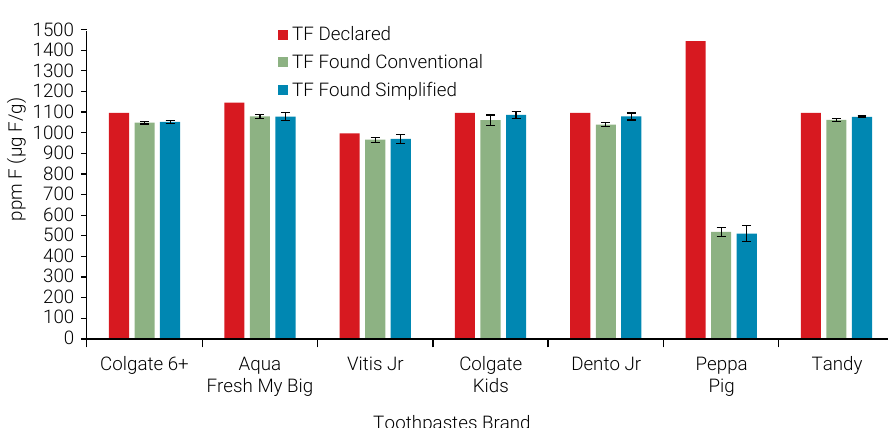
Figure 3. Total fluoride (TF) declared (ppm F) by the manufacturer and concentrations found using the conventional (Ac + ) and the simplified (Ac - ) protocol